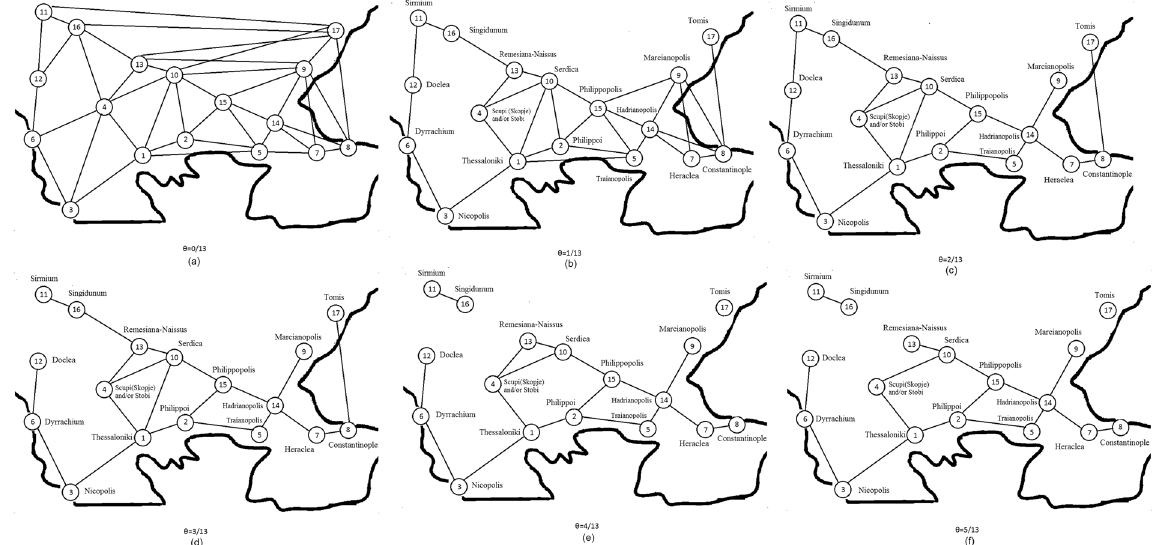
Figure 4. Generalized Physarum graphs P ( θ ) 1 ≤ θ ≤ 5 (Figure from Microsoft paint v. 1607 and data points from Matlab v. R2011b by author N.D.).